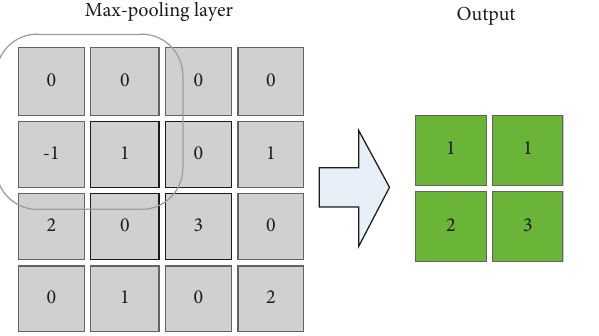
Figure 4: Operating principle of the max-pooling